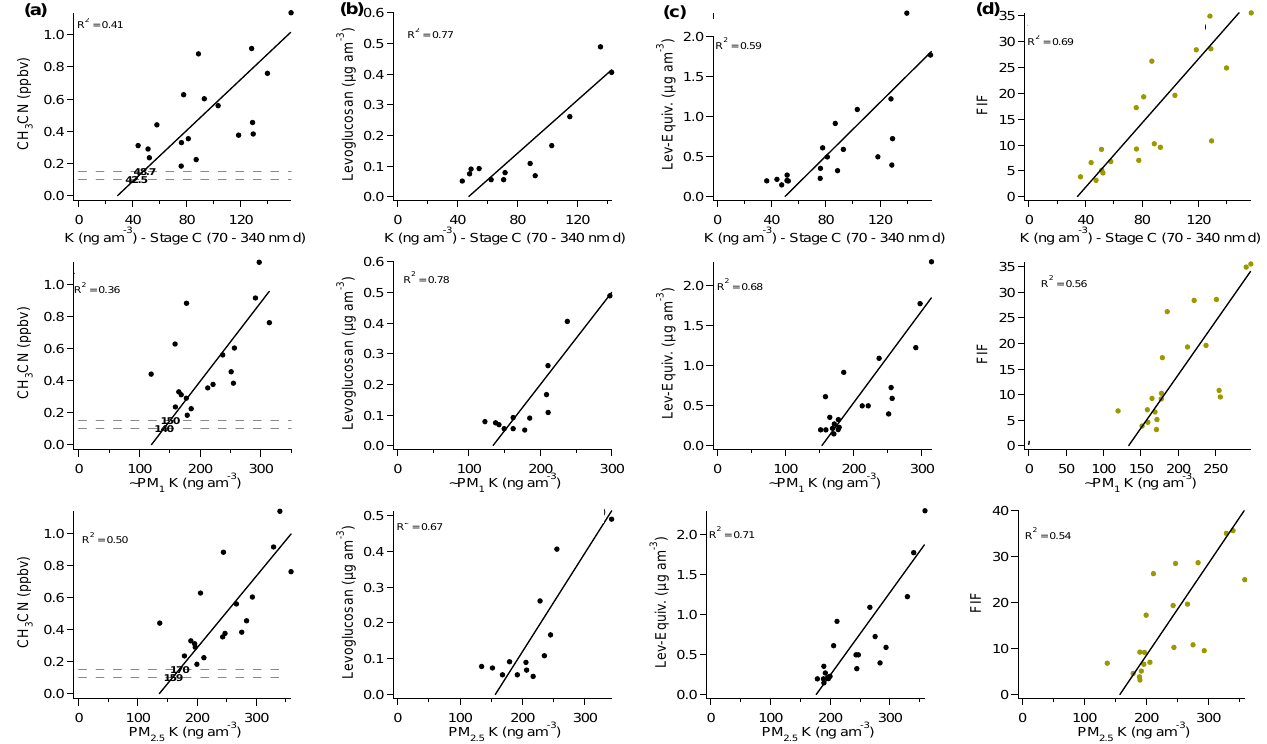
Figure 6. (a) Acetonitrile (PTR-MS) ; (b) Levoglucosan (GC-MS); (c) Levog.-eq. mass (AMS); (d) FIF Fig. 5. (a, b) Gas-phase CH3CN (acetonitrile) vs. AMS levoglucosan-equivalent mass (Aiken et al., 2009), GC-MS levoglucosan (Stone et Potassium plotted as daily time averages. Each scatter plot is shown for the smallest PIXE size bin (70-340 nm), and for approx. PM al., 2008). (c) Scatter plot of levoglucosan-equivalent mass vs. AMS BBOA. and PM . Lines are two-sided robust linear fits. 2.5